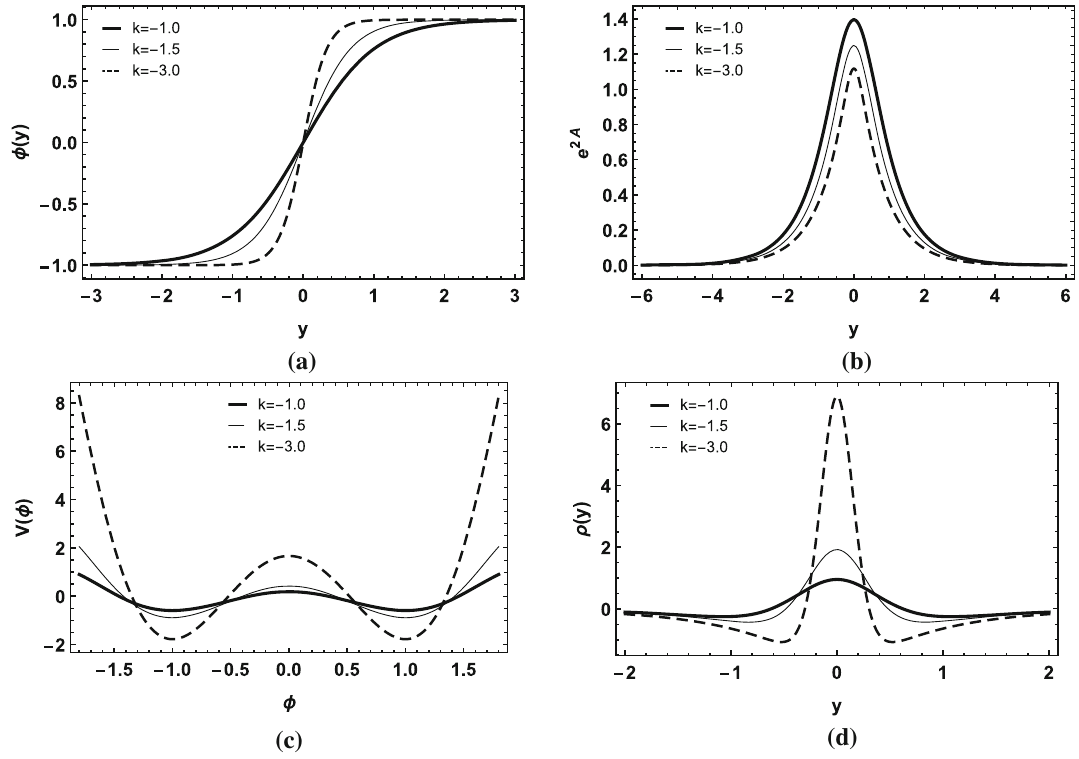
Fig. 1 Plots of the kink solution ( a ), warp factor ( b ), potential ( c ), and energy density ( d ), for the periodical superpotential, where α = β = 1